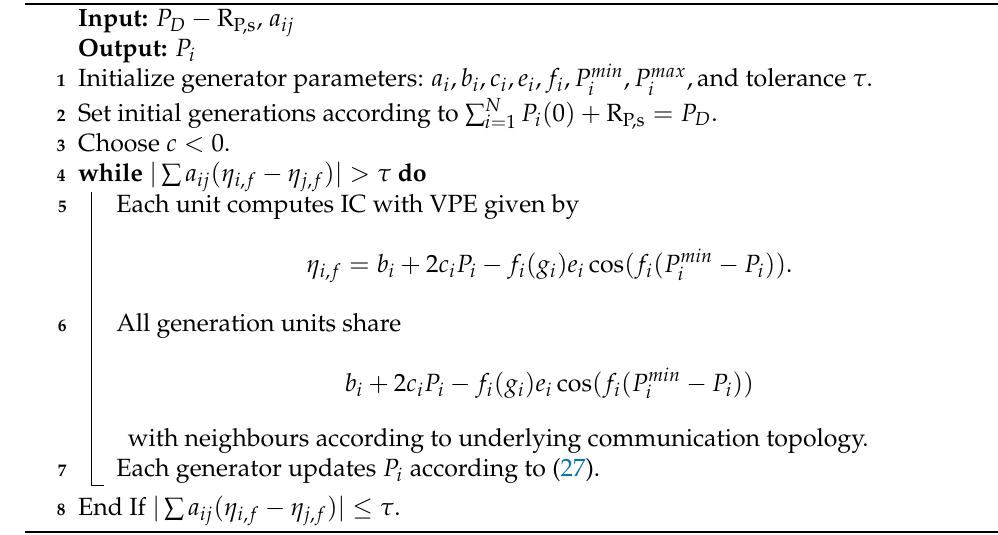
Algorithm 1: Algorithm to solve EDP with VPE and